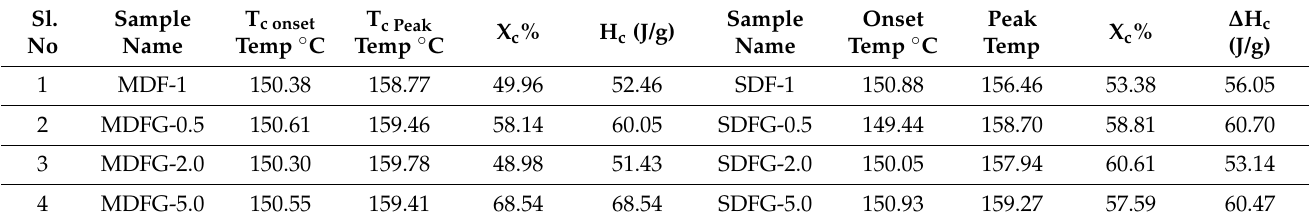
Table 2. Summary of DSC